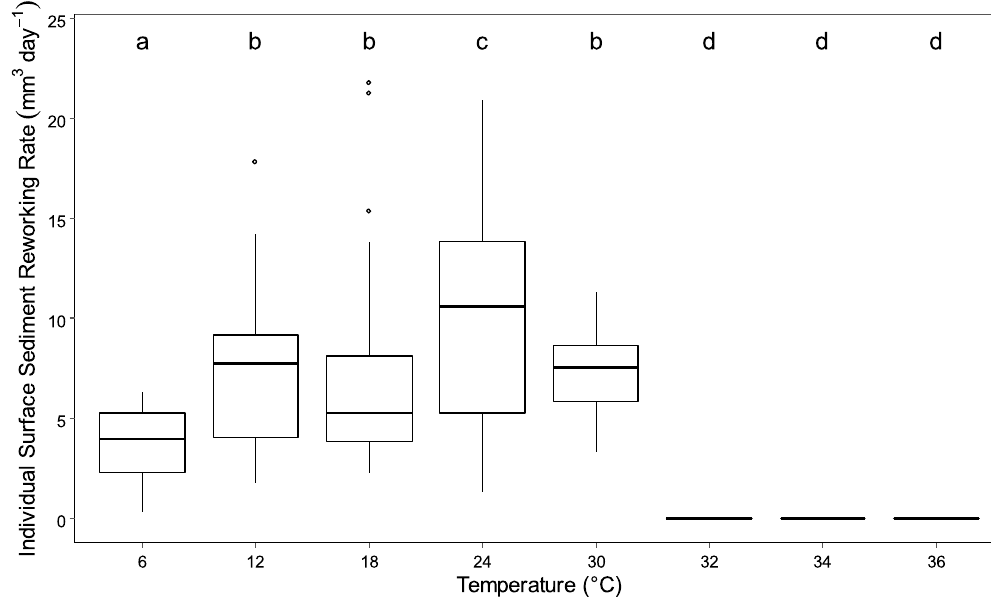
Figure 6. Individual surface sediment reworking (mm 3 indiv −1 day −1 ) of H. germanica under different thermal regime. Letters above plots (‘a’, ‘b’, ‘c’) indicate significant differences among measurements (Dunn test, p < 0.05). The box represents the first, second and third quartiles and the whiskers extend to 1.5 times the interquartile range; values outside this range are represented by open circles.